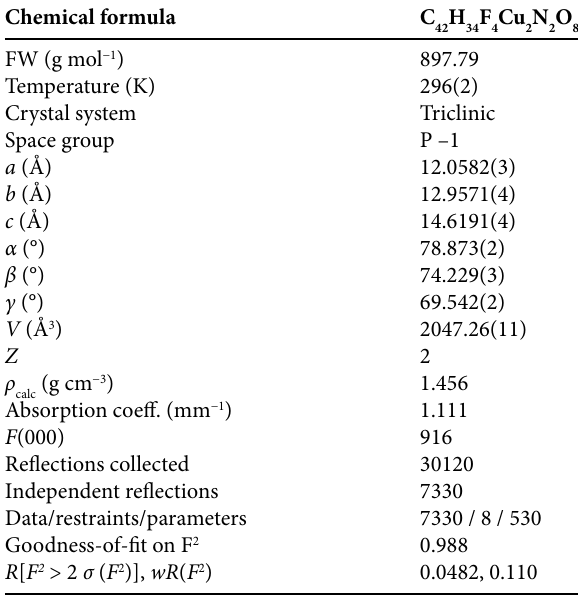
Table 1. Structure refinement parameters of the